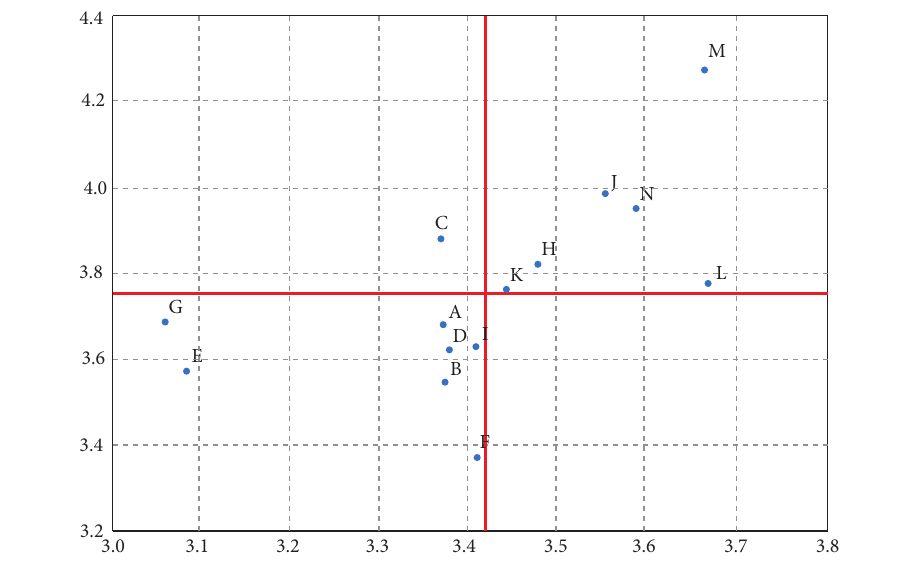
Fig. 5. The scatter diagram of parameters of relations of Polish enterprises with the material supplier